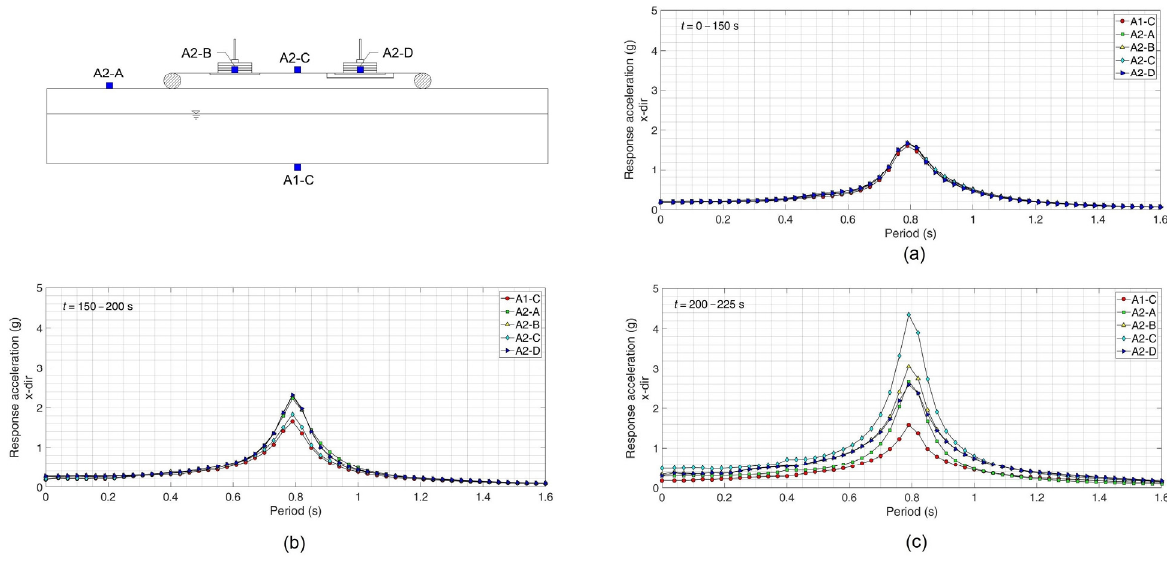
Figure 17. Variation of horizontal elastic response spectra: ( a ) t = 0–150 s, ( b ) t = 150–200 s, and ( c ) t = 200–225 s.